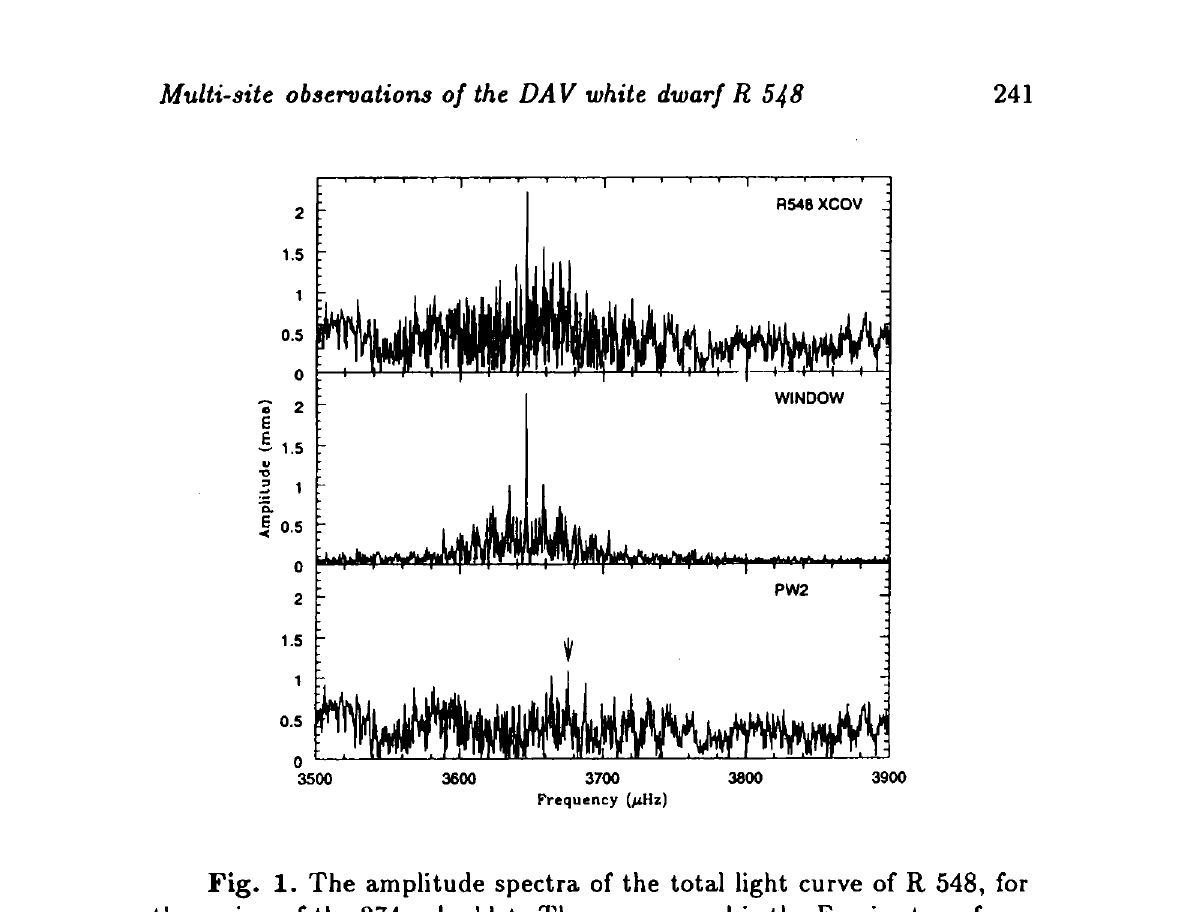
Fig. 1. The amplitude spectra of the total light curve of R 548, for the region of the 274 s doublet. The upper panel is the Fourier transform of the data. The second panel (WINDOW) is the spectral window, i.e., the transform of a noiseless sine-curve. The third panel (PW2) is the Fourier transform after removing (pre-whitening) the known doublet at P= 274.25 s, Amp — 2.17 mma and P= 274.77 s, Amp- 1.32 mma. The largest peak left is at P= 272.04 s, Amp= 1.09 mma. This peak is only at 2 </!>, but it has the same window structure as the other